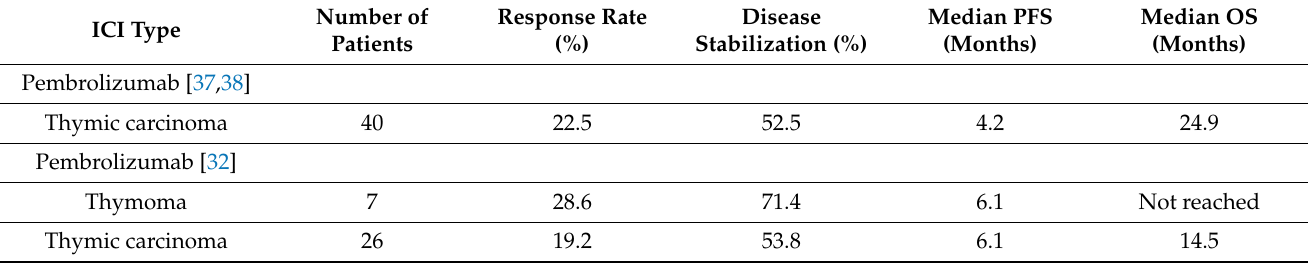
Table 1. Clinical activity of immune checkpoint inhibitors in patients with thymic epithelial